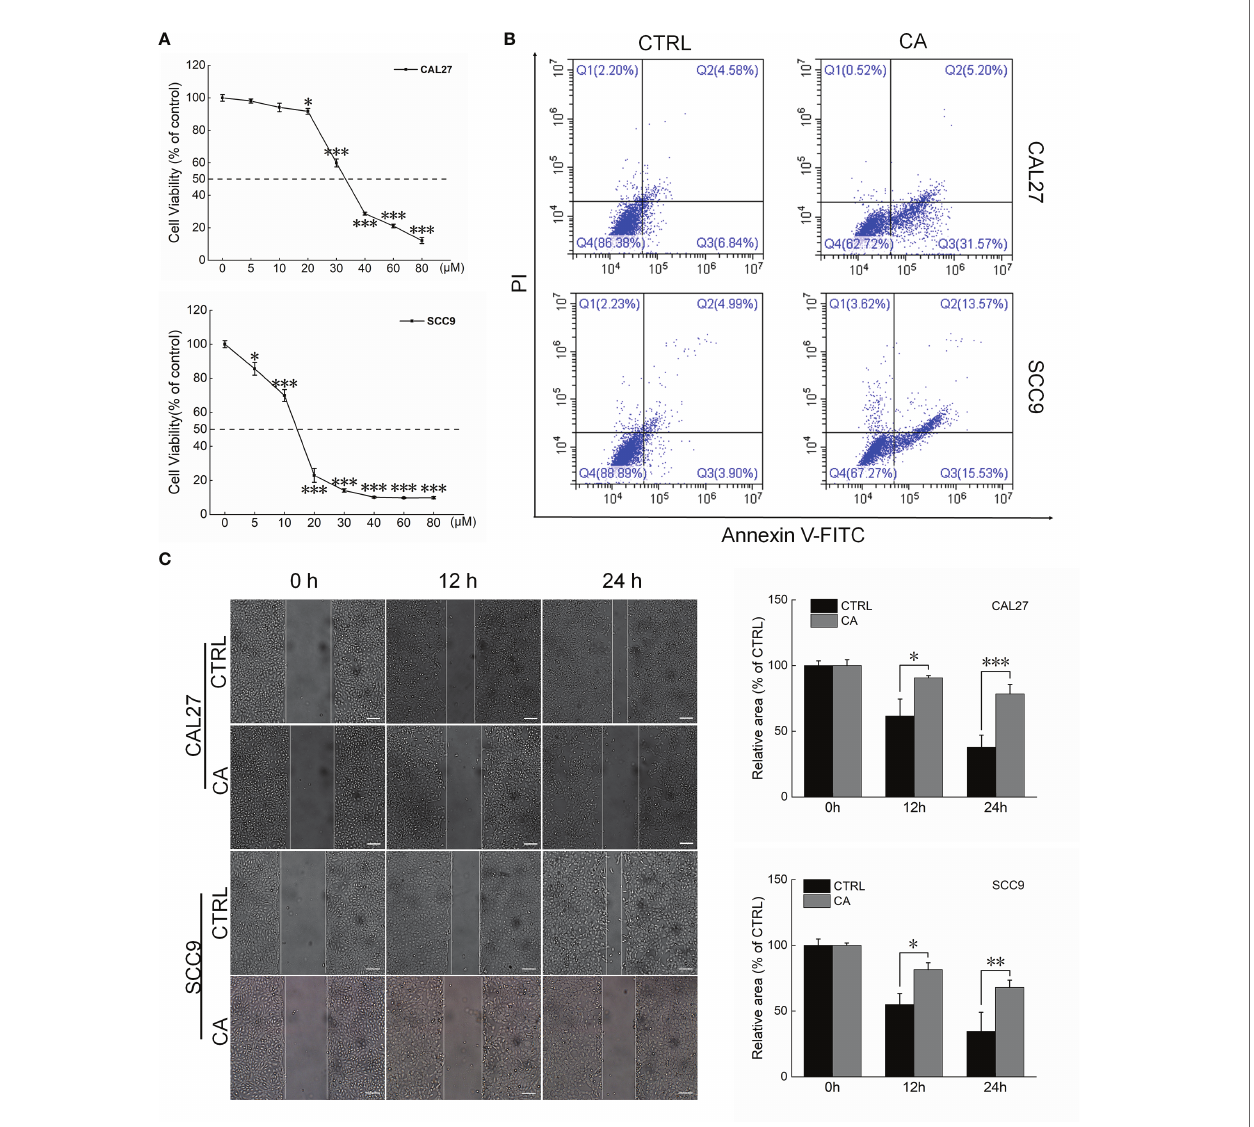
FIGURE 1 | CA treatment affected the cell viability and promoted apoptosis in OSCC cells. (A) CA treatment for 24 h reduced the viability of CAL27 and SCC9 cells in a dose-dependent manner ( n = 3). (B) CA treatment increased the apoptosis rates of CAL27 and SCC9 cells ( n = 3). (C) CA treatment signi fi cantly inhibited the migration of CAL27 and SCC9 cells over time ( n = 3) (200× magni fi cation, scale bar: 50 m m). The data are expressed as mean ± SEM. * P < 0.05, ** P < 0.01 and *** P < 0.001 versus the control